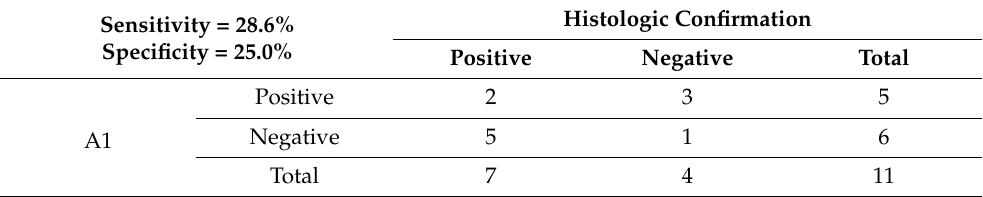
Table 4. Sensitivity and specificity of 68 Ga-DOTATOC-PET/CT A1 with histologic confirmation. Sensitivity =